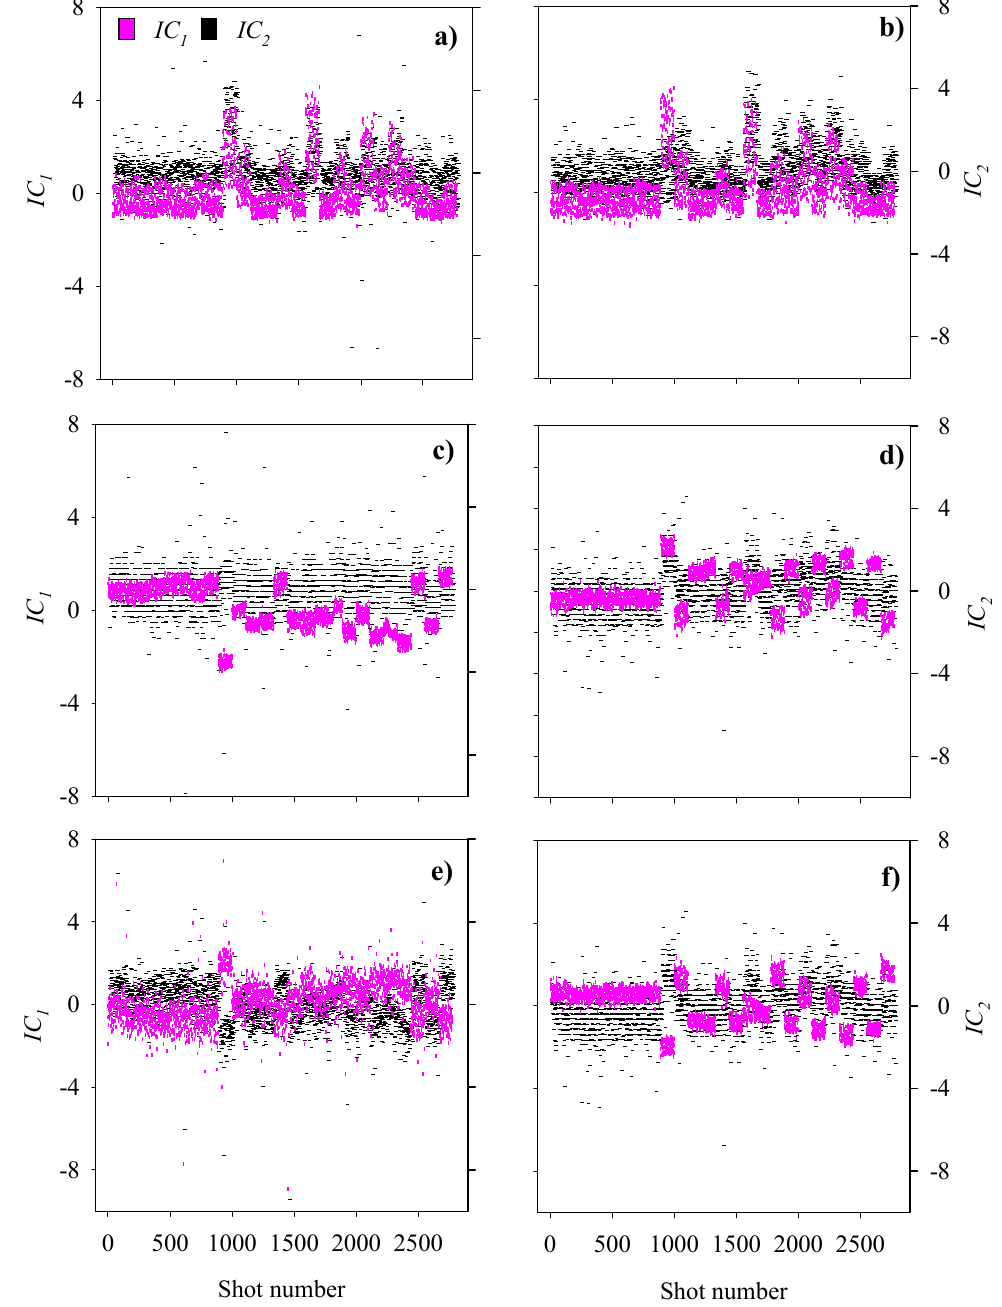
Figure 5. ICA components associated with direct- (IC 1 , black dots) and diffuse-dominated (IC 2 ,magenta dots) backscattering components. λ = 473 nm ( left panels , a , c , e ), λ = 532 nm ( right panels , b , d , f ), time bin 110 ( top panels , a , b ), 160 ( middle panels , c , d ) and 270 ( bottom panels , e , f ).